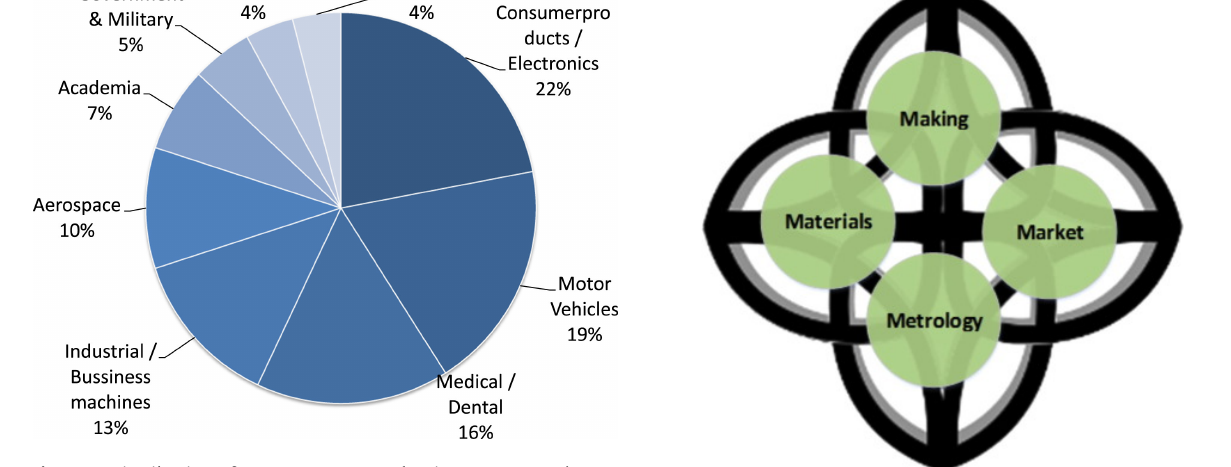
Figure 1: Distribution of AM revenues over business sectors show- ing the widespread application [4]